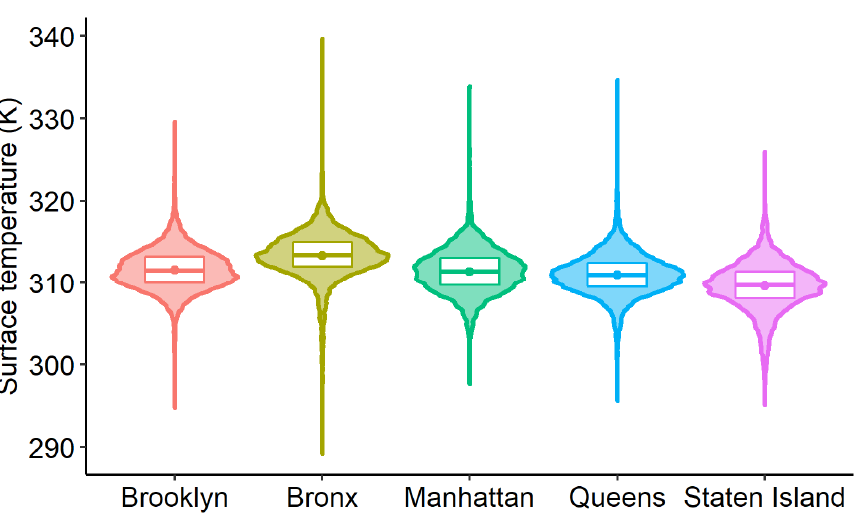
Figure 5. The violin chart with boxes represents the interquartile range (IQR) of surface temperature in five boroughs of New York City. Mean (filled circle) and median (full line inside the box) is also shown.